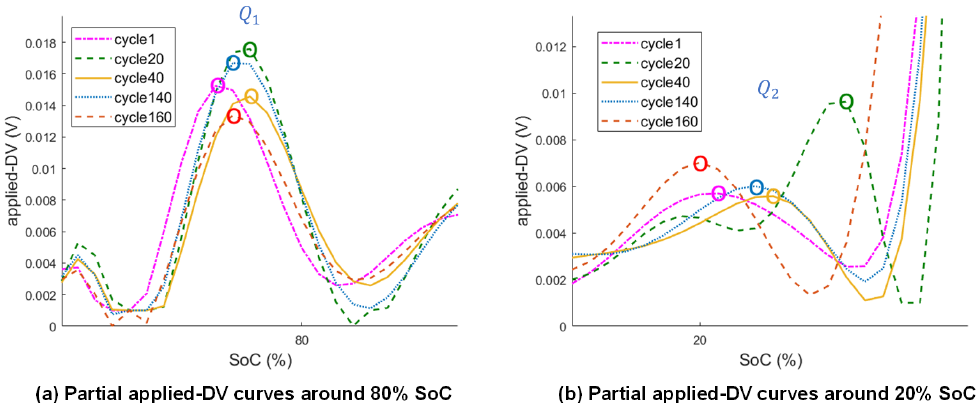
Figure 18. Partial applied-DV curves around 80% and 20% SoC.